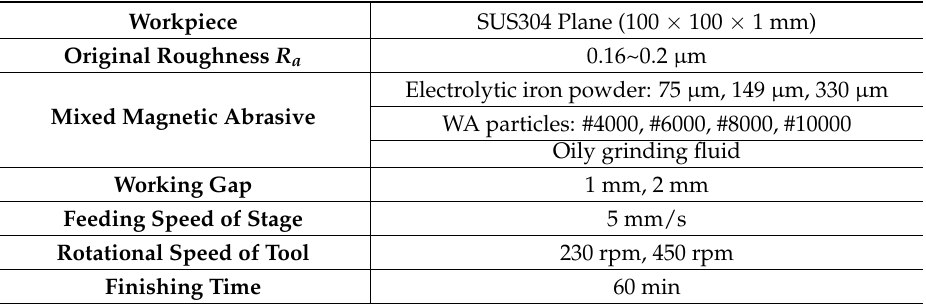
Table 1. Experimental conditions of the magnetic abrasive finishing (MAF) process.